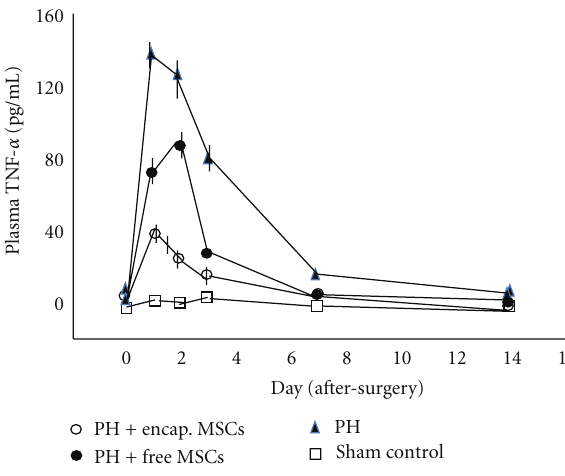
Figure 5: IL-6 in plasma.